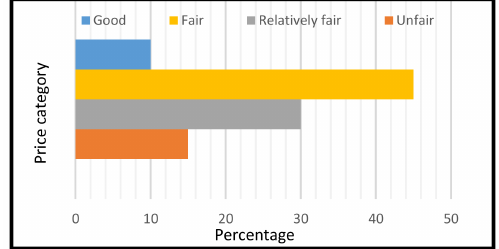
Figure 16. Satisfaction level with the selling